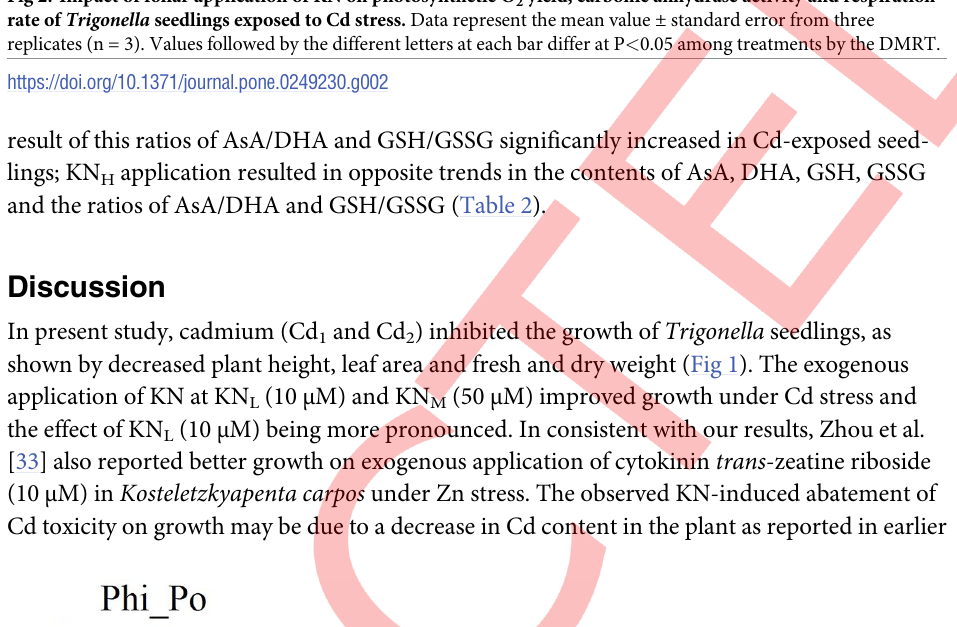
PLOS ONE | https://doi.org/10.1371/journal.pone.0249230 June 22,